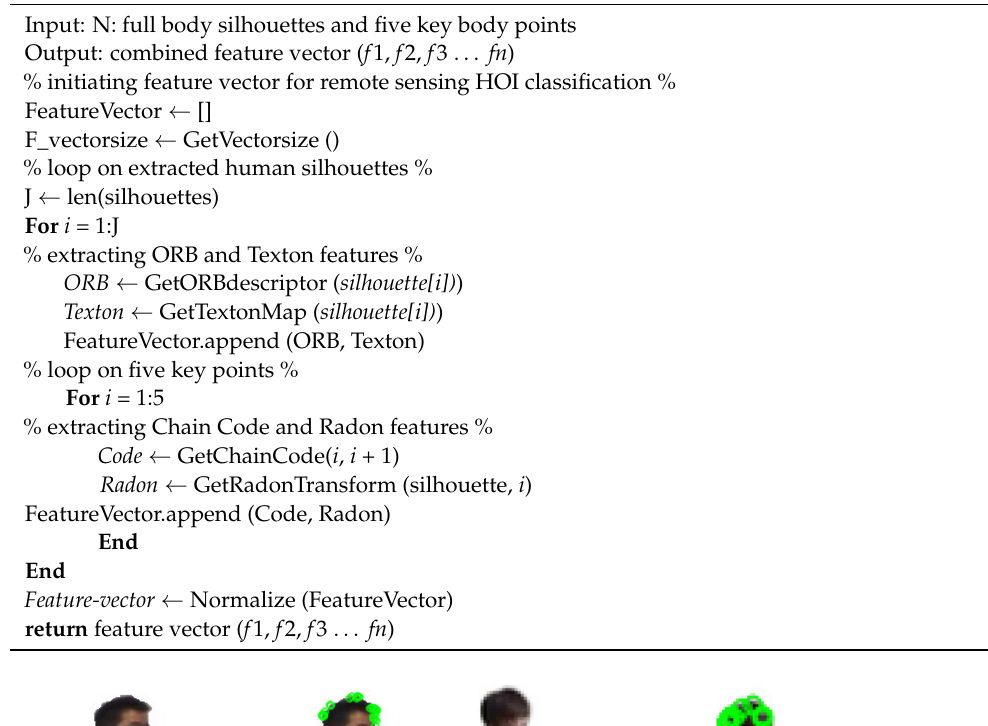
Algorithm 3: Multi-Scale Feature Extraction